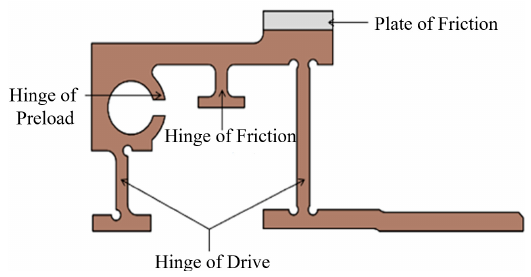
Figure 7. Zoom in hinges. Figure 7. Zoom in